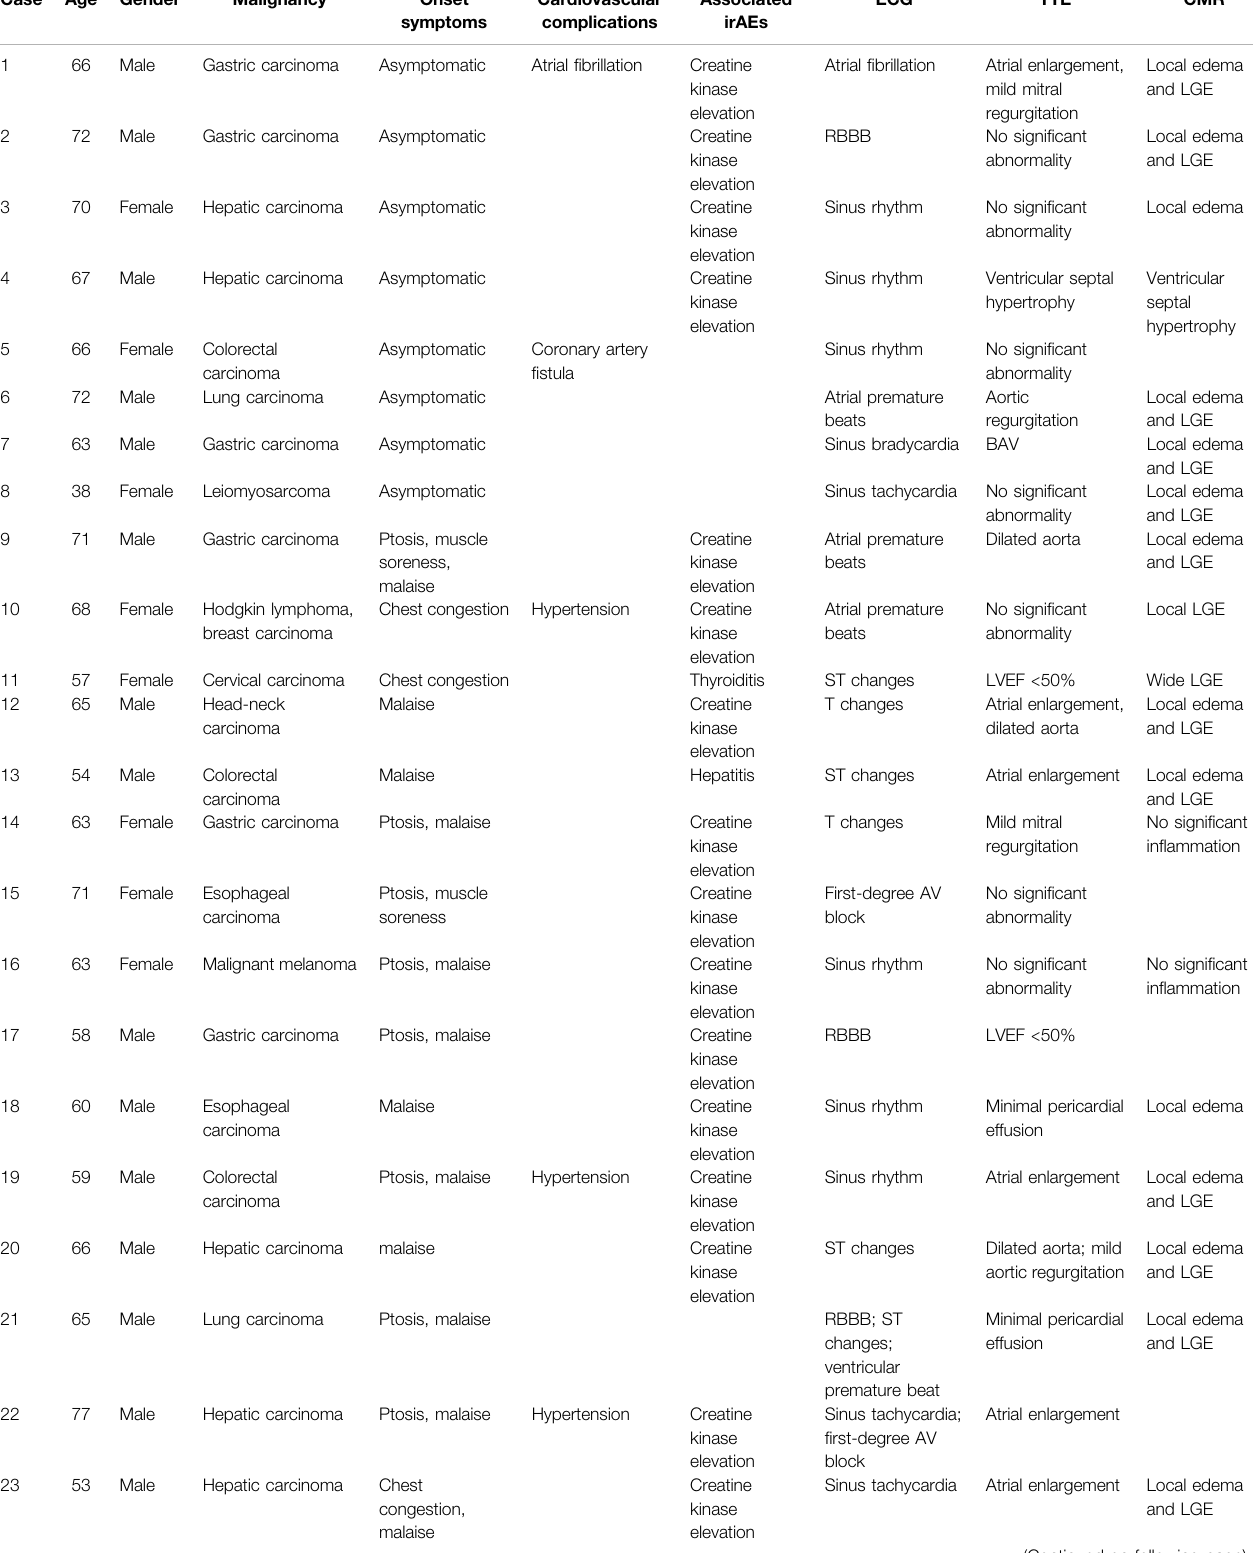
TABLE 1 | Baseline characteristics in patients with ICI-associated